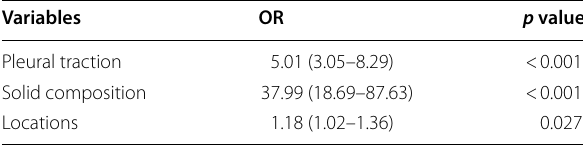
Table 4 Univariate logistic analysis of clinical features and lymph node metastasis